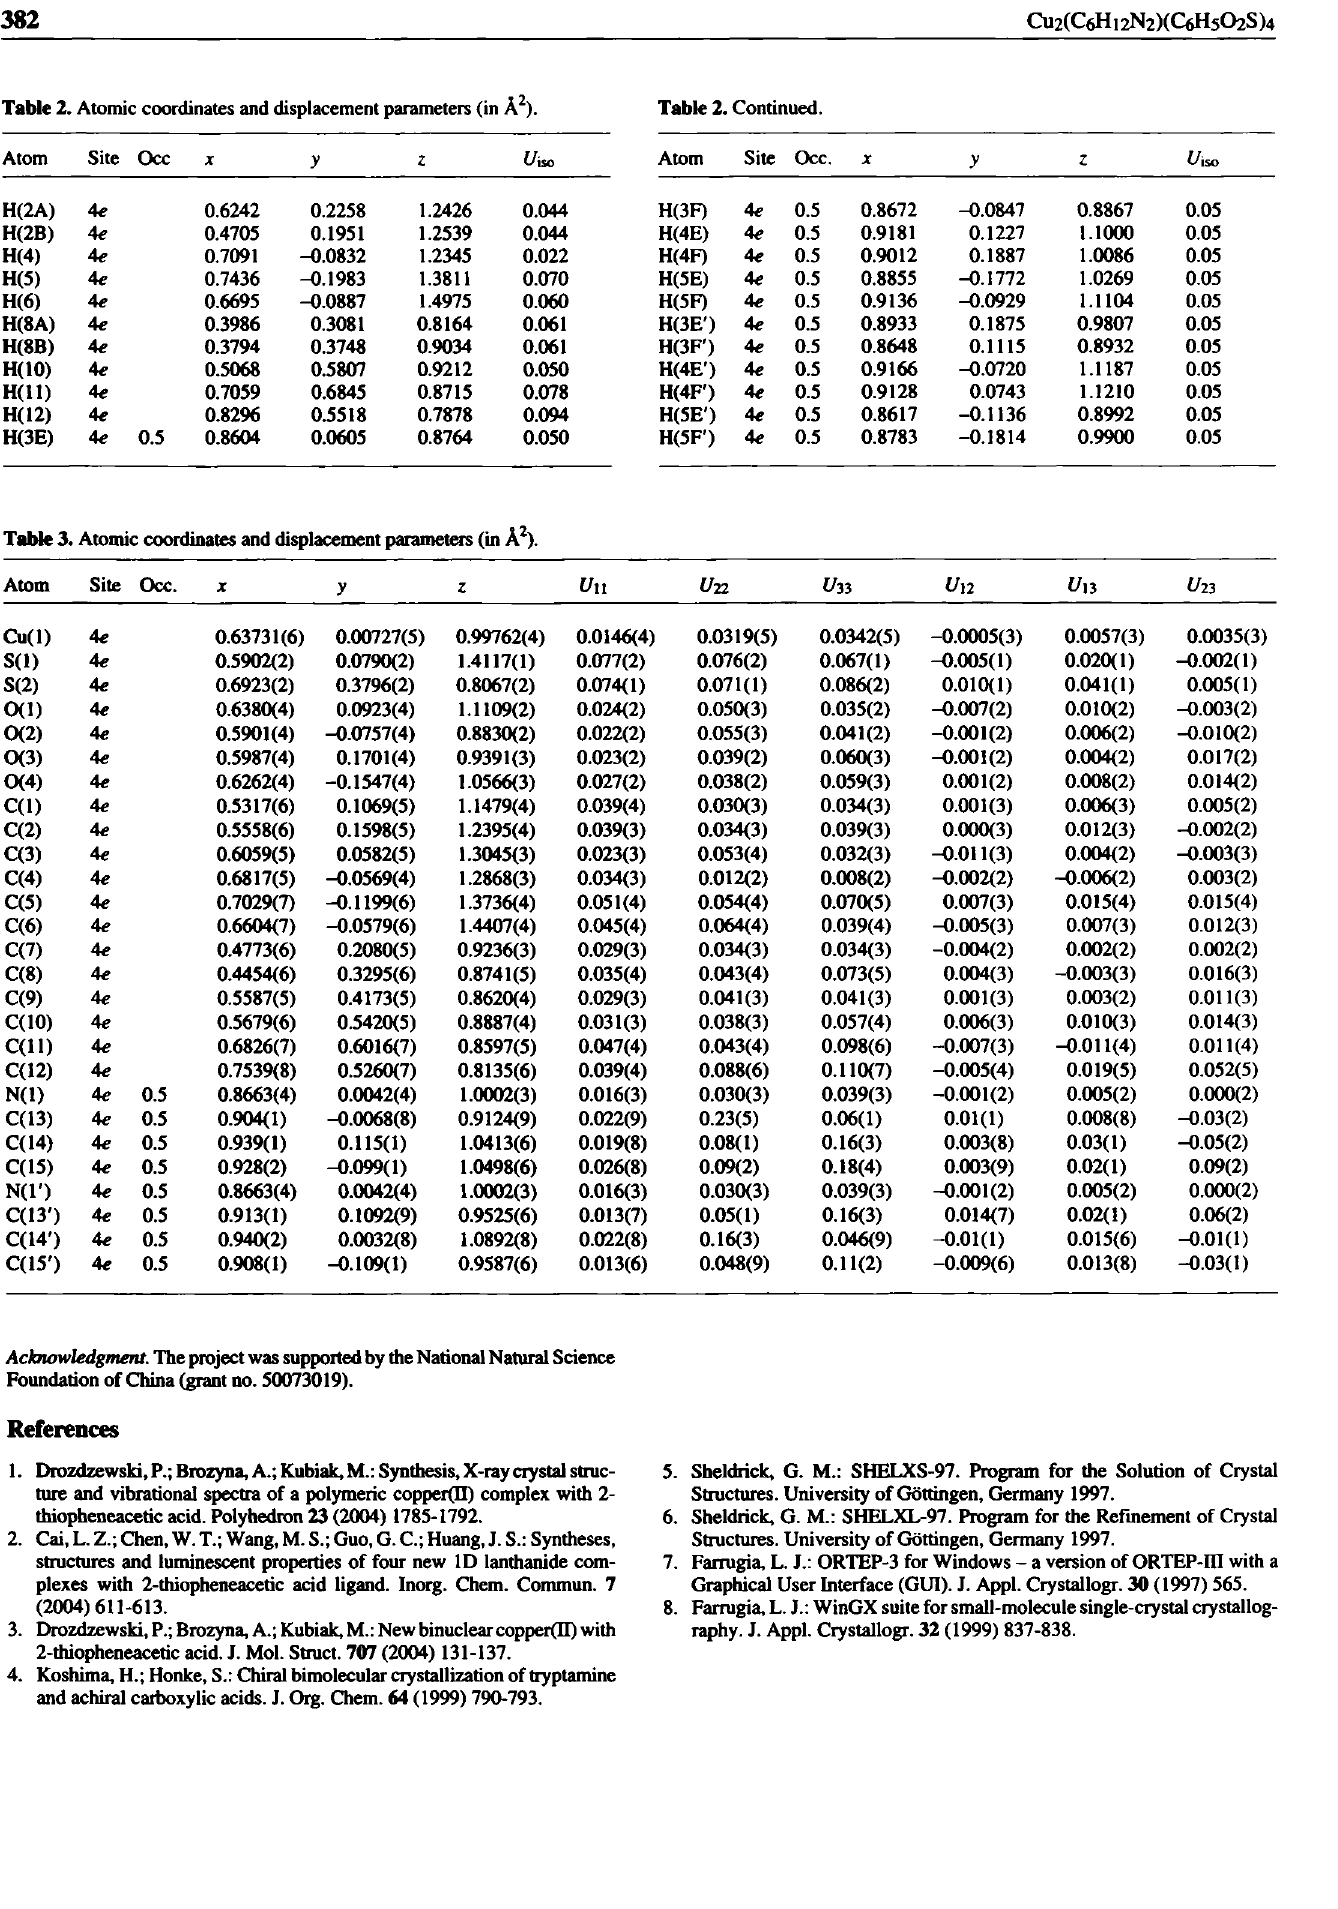
Table 2. Atomic coordinates and displacement parameters (in Ä 2 ).